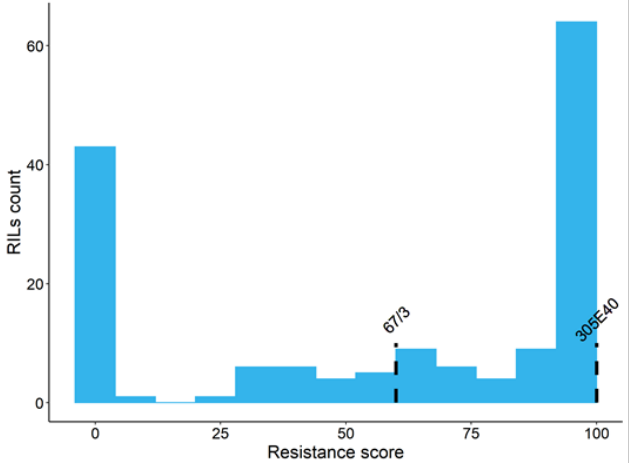
Figure 3. Distribution of the resistance score in the RIL population. The scores values of the two parental lines ‘67/3’ and ‘305E40’ are highlighted with dashed lines.